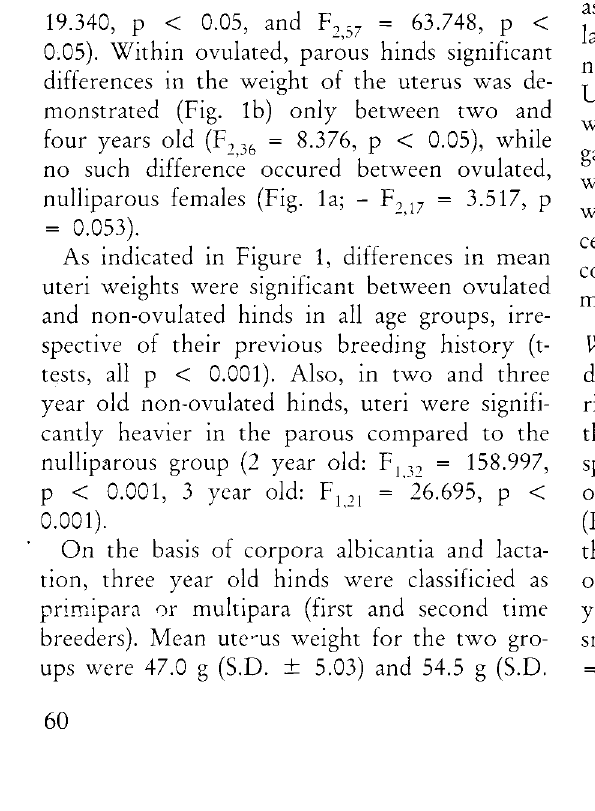
Fig. 1. Mean weight of uteri (± 95% confidence li mits) for nulliparous (a) and parous (b) red deer females. Circles = non-ovlulated, square¬ s = ovulated. Sample size in